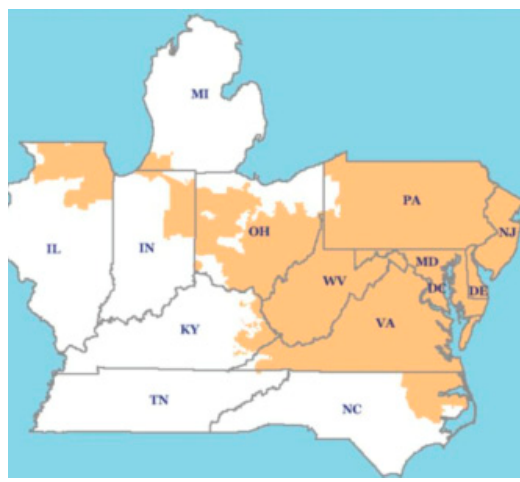
Figure 4. Map of Pennsylvania-New Jersey-Maryland (PJM) [25].